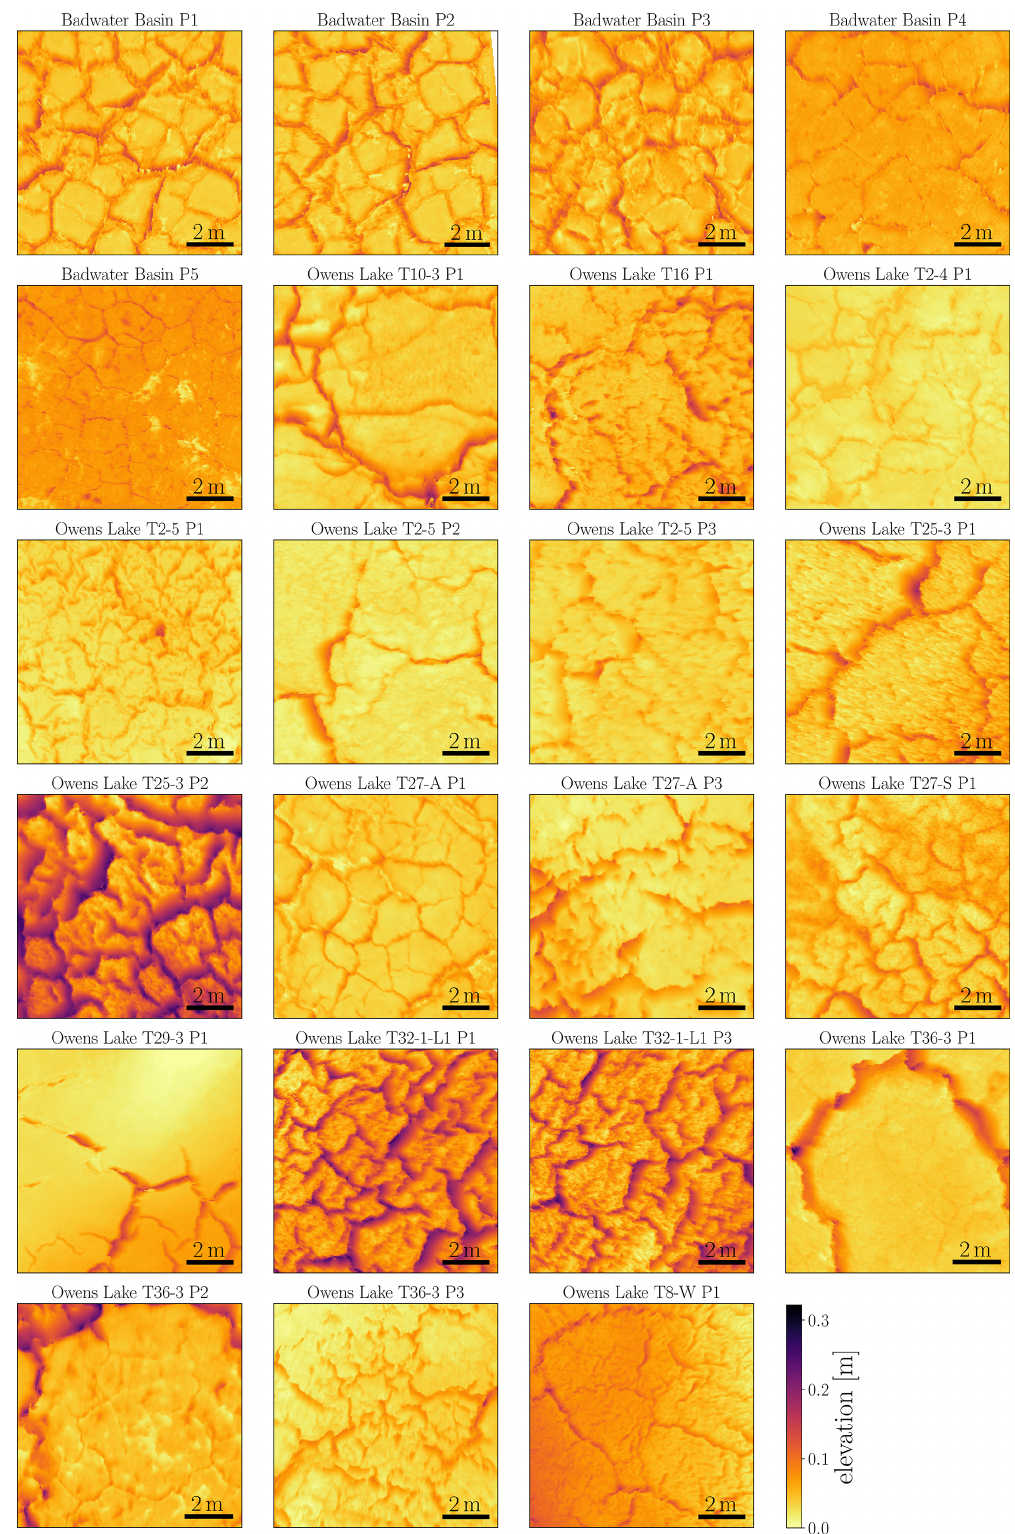
Figure 8. Gridded subsets of the surface relief measured by TLS at sites at Owens Lake and Badwater Basin. The elevation reflects the surface height above the lowest point in each